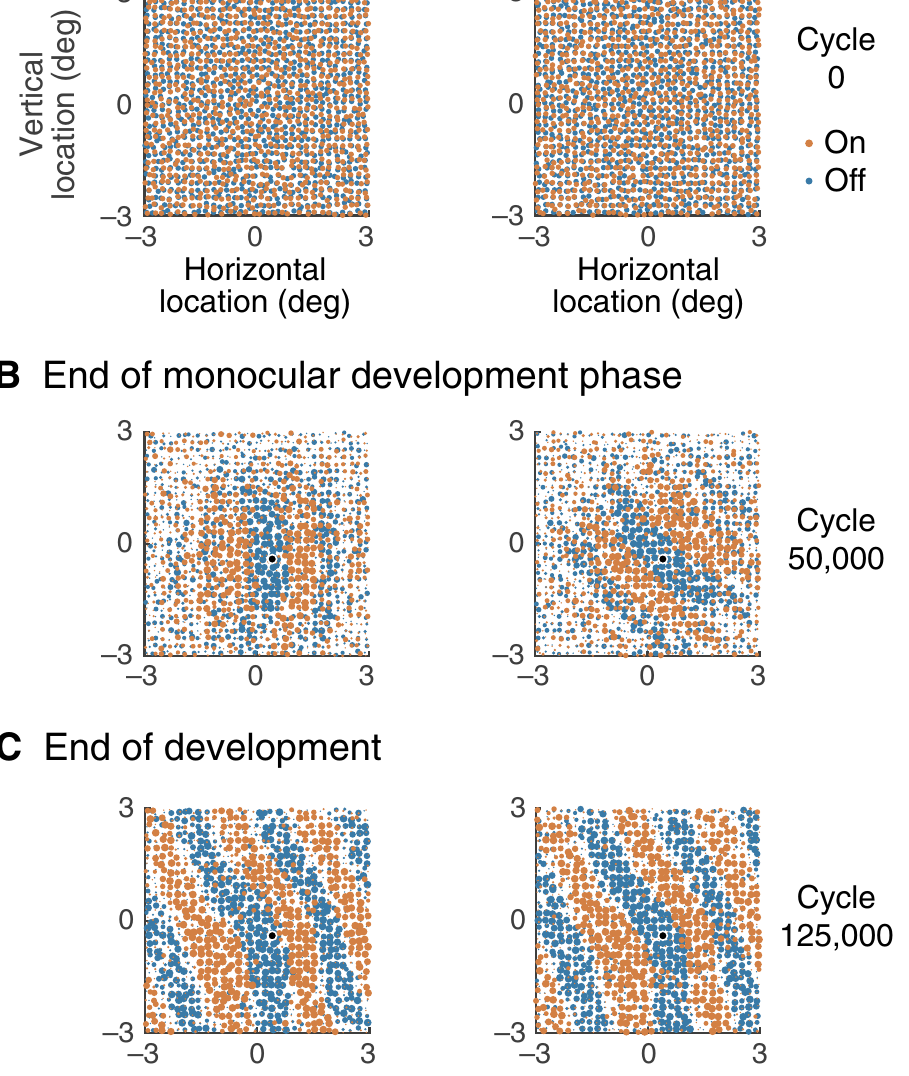
Figure 2. Development process. ( A ) Each dot gives the visual field location of a single subcortical channel, with red and blue for on- and off-centre channels respectively. The spatial arrays are uncorrelated between eyes. ( B ) The plots in ( B ) and ( C ) show geniculocortical synaptic weights for the (excitatory) cortical neuron located at the black dot; red and blue dot diameter indicates the synapse’s modulation factor. Cortical inputs from neighbouring channels of opposite sign tend to cancel each other before development, resulting in very weak cortical signals. Hebbian development in the geniculocortical synapses strengthened cortical responses by segregating on- and off-centre channels. Simulation in the first development phase is monocular, however, so the orientation of segregation is independent between the eyes. ( C ) Stimulation in the second phase of development is binocular, so synaptic modulations adjust to minimise cancellation of one eye’s signals by those from the other eye. Interocular differences in segregation therefore